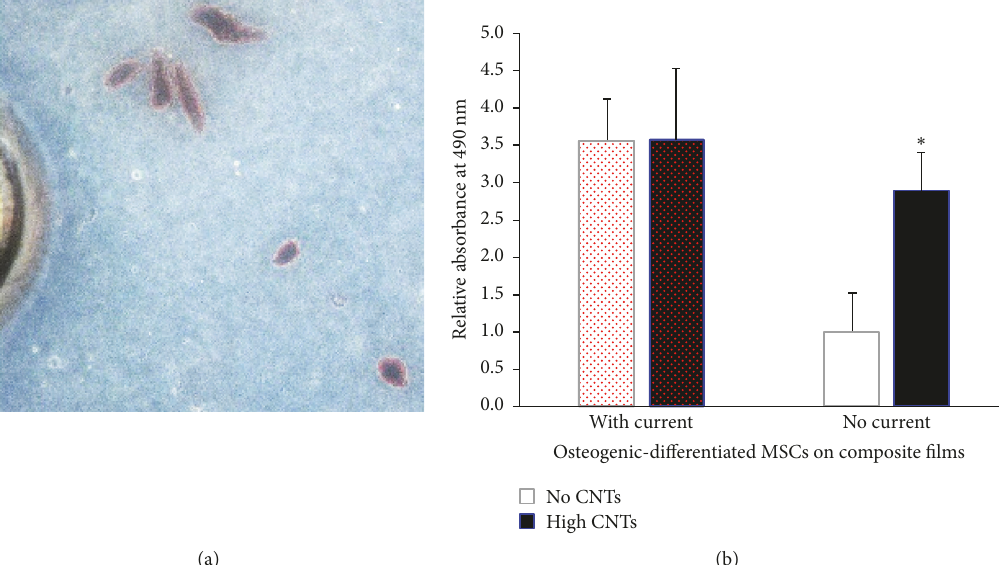
Figure 7: (a) A representative image of Alizarin Red S-stained cell clusters on the surface of no CNTs silicone-collagen film. (b) Absorbance spectroscopy at 490 nm (red intensity) of DMSO-solubilized Alizarin Red S-calcium crystals on composites with high CNTs and no CNTs, with applied electrical stimulation (with current) and without it (no current control). ∗ 𝑝 < 0.05 for high CNTs versus no CNTs at a no current condition.